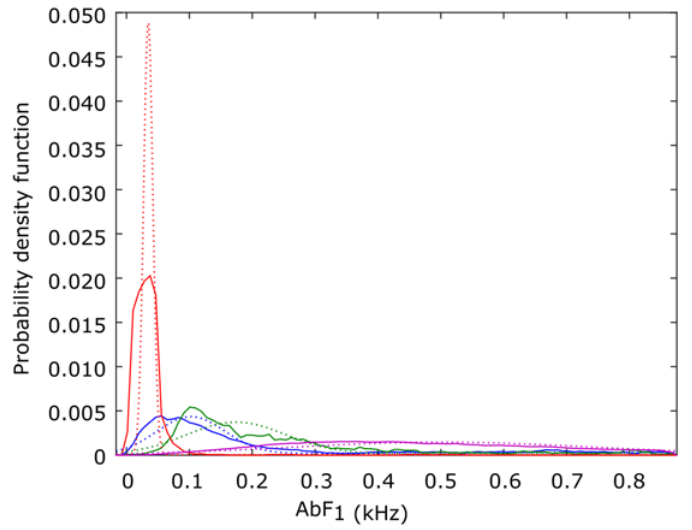
Figure 13. Probability density functions for each descriptor.